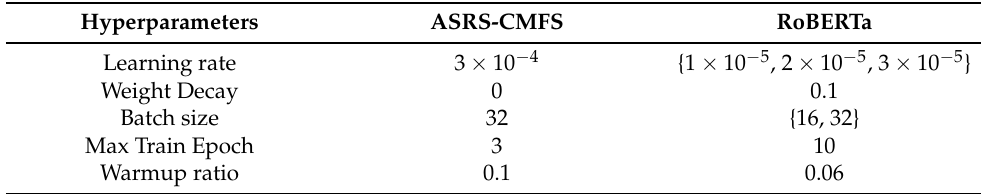
Table 9. Comparison of fine-tuning